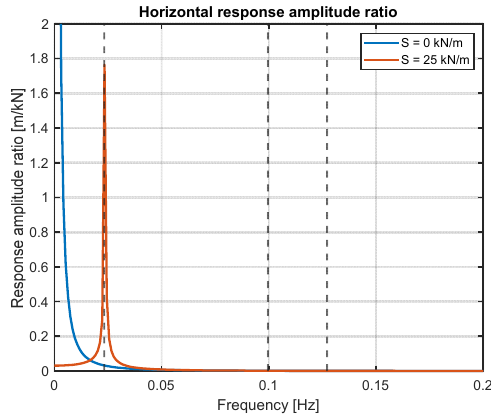
Figure 18. Case 2, Minimum diameter, pre-tension 30 kN.